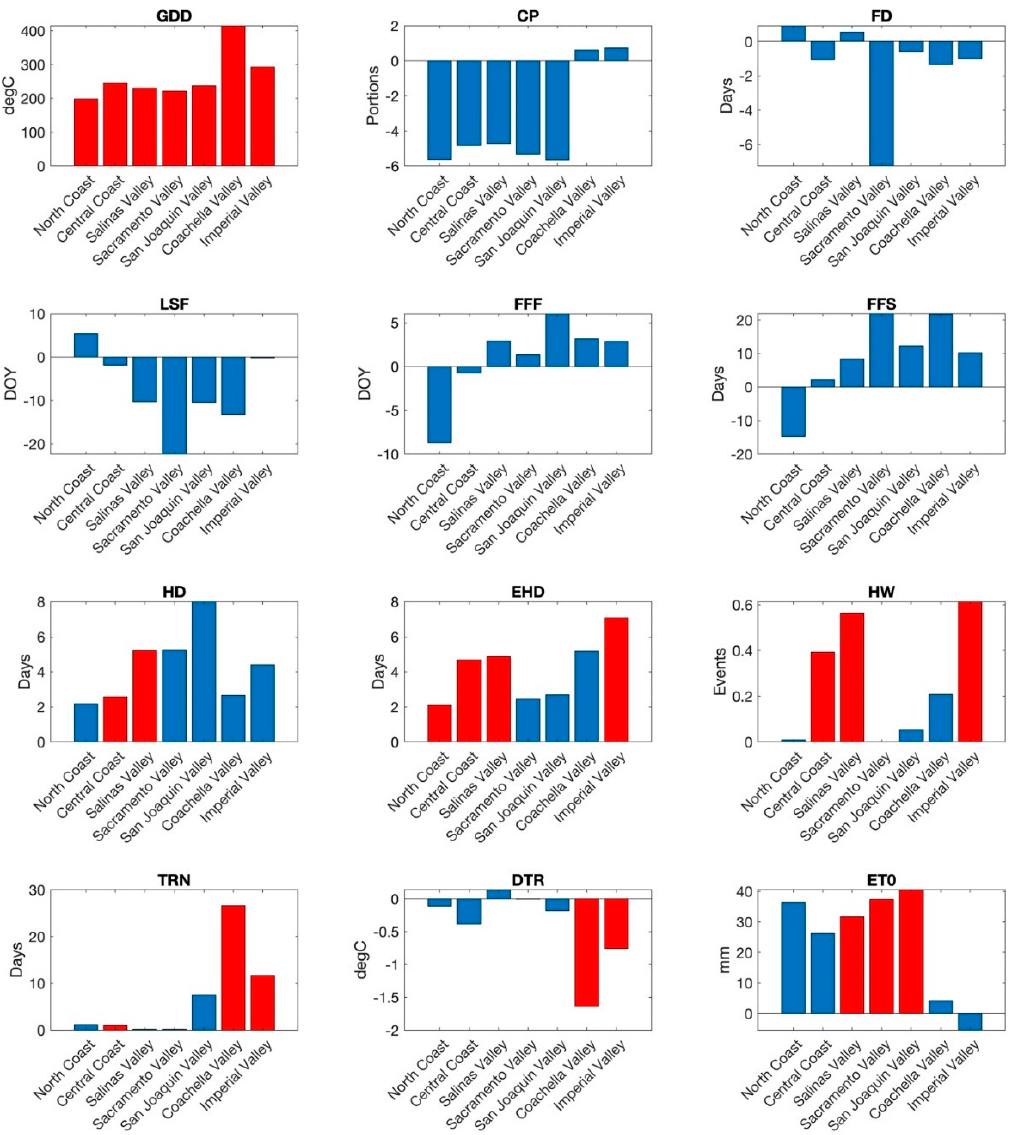
Figure 3. Trends in 12 agroclimate metrics over the 40-year (1981–2020) period averaged over crop locations in each agricultural region. Trends are per year. Metrics in red are statistically significant. Metrics are shown as: row 1: growing degree days (GDD), chill portions (CP), frost days (FD); row 2: last spring freeze (LSF), first fall freeze (FFF), frost-free season (FFS); row 3: heat days (HD), extreme heat days (EHD), heatwaves (HW); row 4: tropical nights (TRN), diurnal temperature range (DTR), summer reference evapotranspiration (ETo).